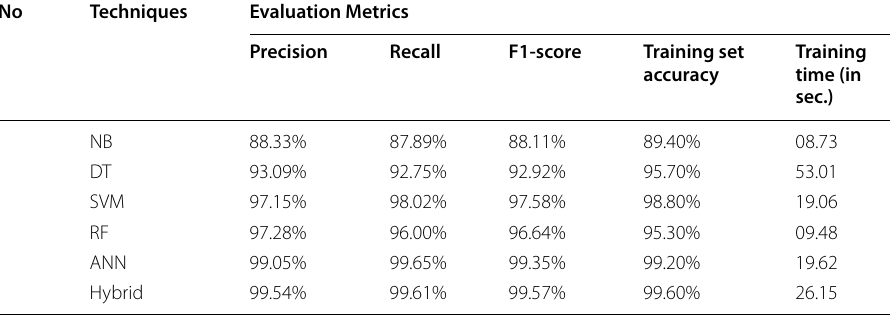
Table 8 Performance evaluation for the training set No Techniques